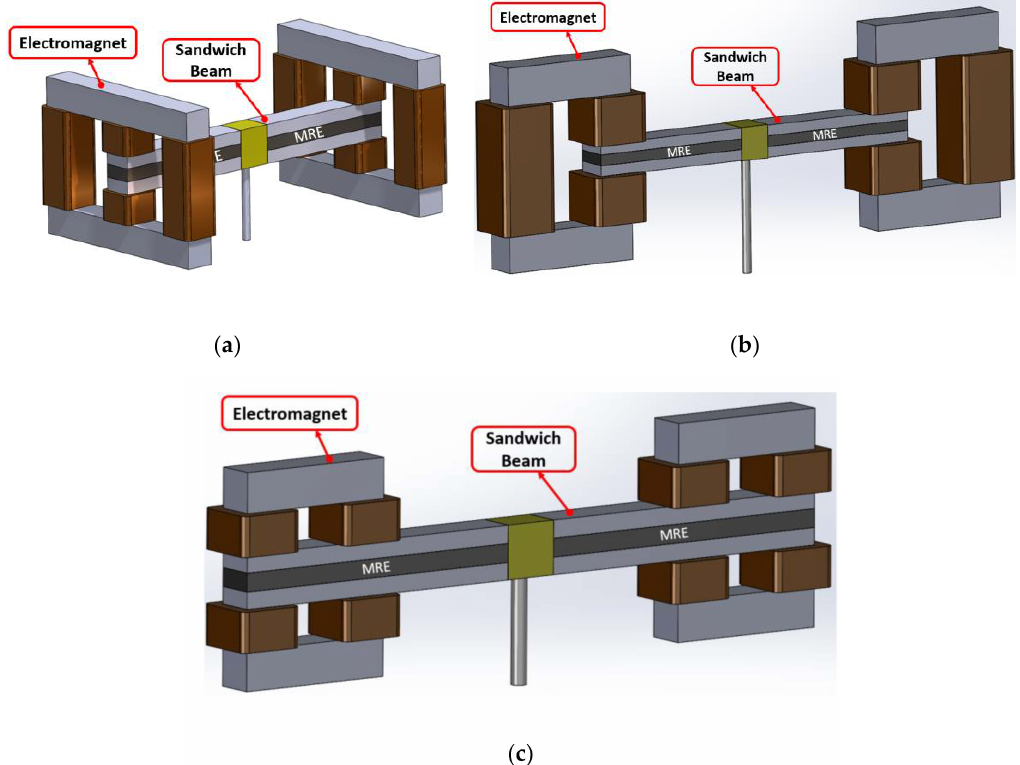
Figure 3. Schematics of the assembled ATVA structure with each of the three electromagnet designs. ( a ) H-shaped electromagnet; ( b ) C-shaped electromagnet; and ( c ) U-shaped